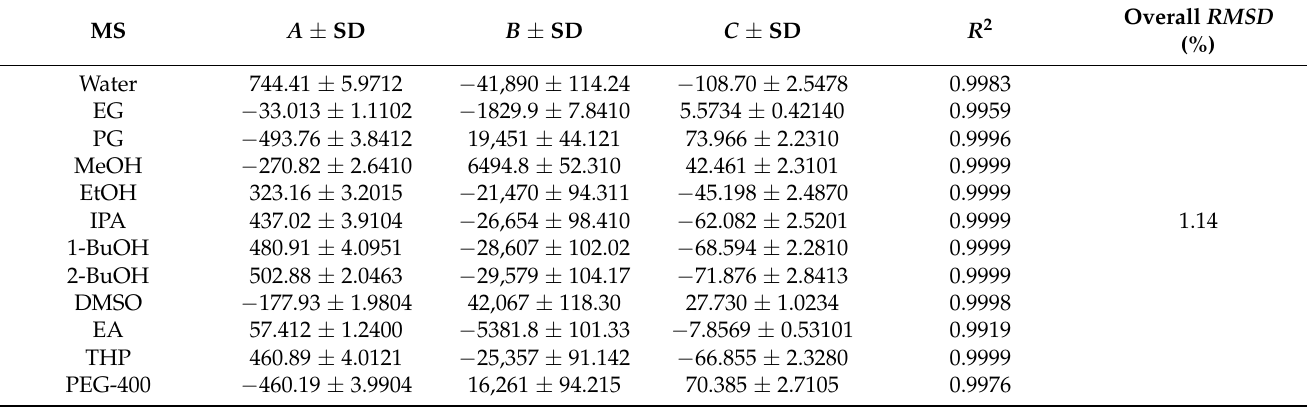
Table 4. Apelblat model results for FBX in several MS in terms of model parameters ( A , B and C ), R 2 , and root mean square deviation ( RMSD